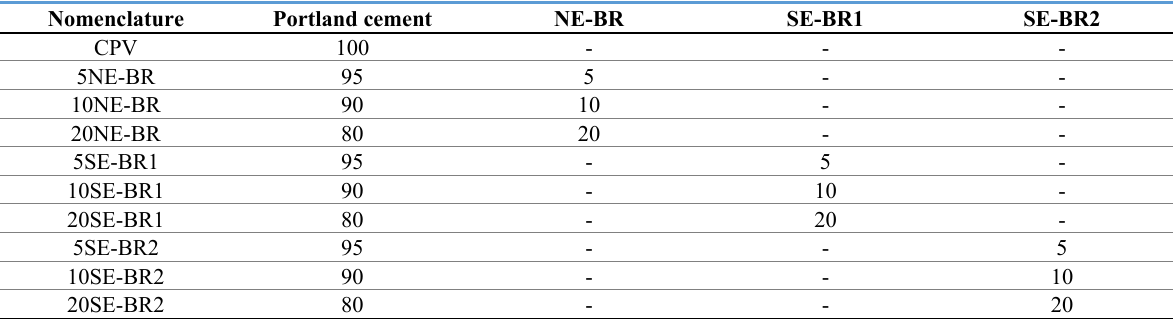
Table 1 C ompositions evaluated in the